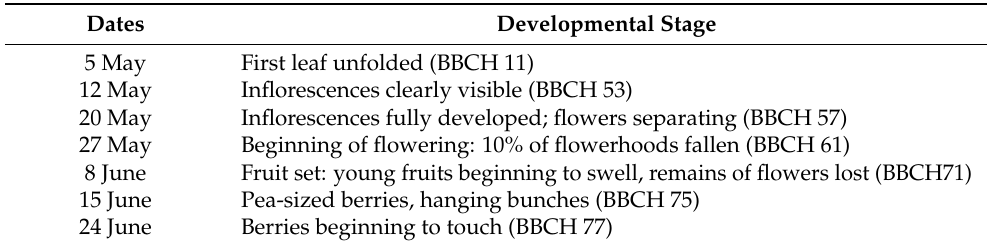
Table 2. Treatment schedule: dates of application and vegetative development stage of the grapevine plants at each time of